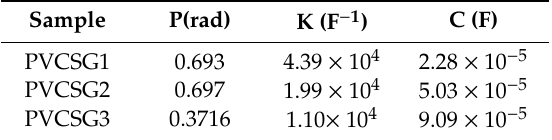
Table 1. EEC fitting parameters for PVA:CS: LiClO 4 : glycerol systems at room temperature.